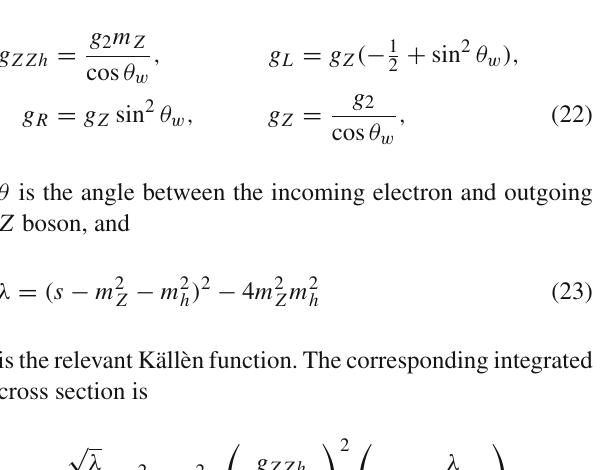
the spin-averaged matrix element. Here the couplings